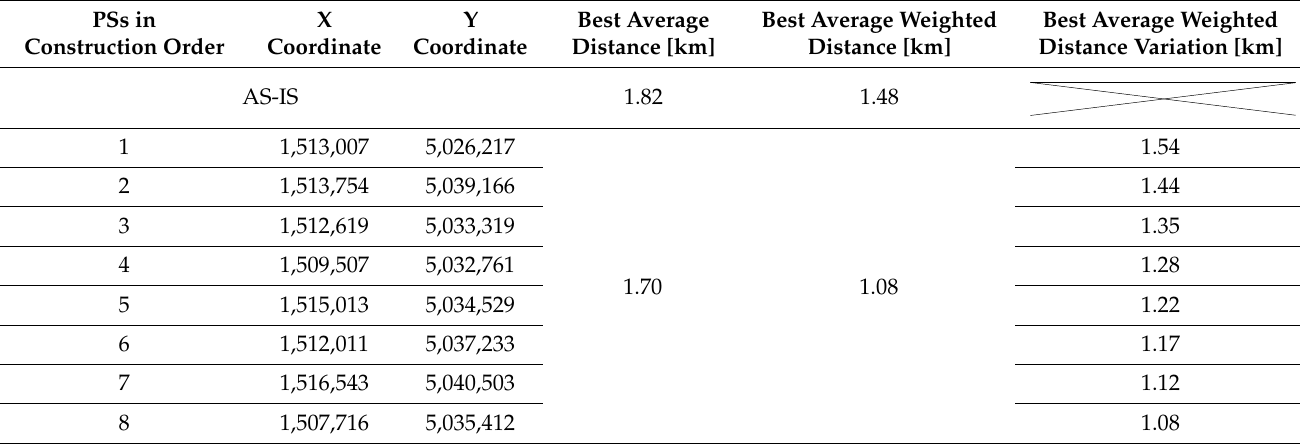
Table 5. Timing, siting of the new eight PSs, and best average weighted distance values. Figure 14. Example of siting two new PSs among several others already in place. New PSs are in red